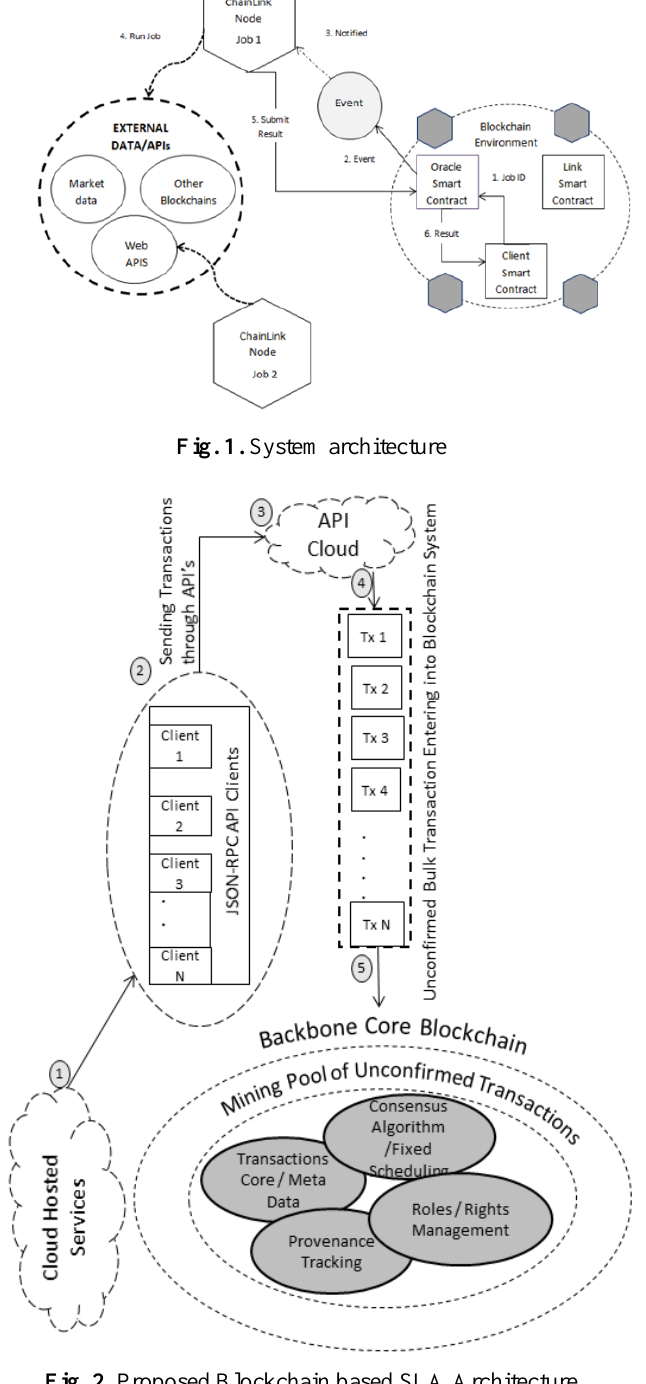
Fig. 2. Proposed Blockchain based SLA Architecture without